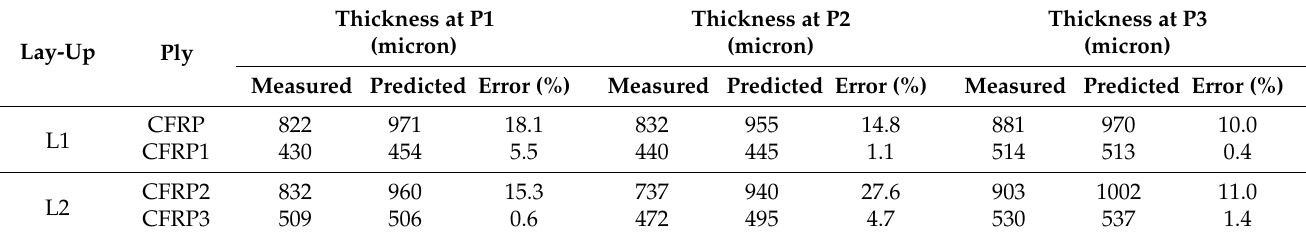
Figure 11. Experimental and predicted cross-sections of lay-ups ( a ) L1 and ( b ) L2. Table 6. Measured and predicted thickness of the deformed multilayered FML (constant friction